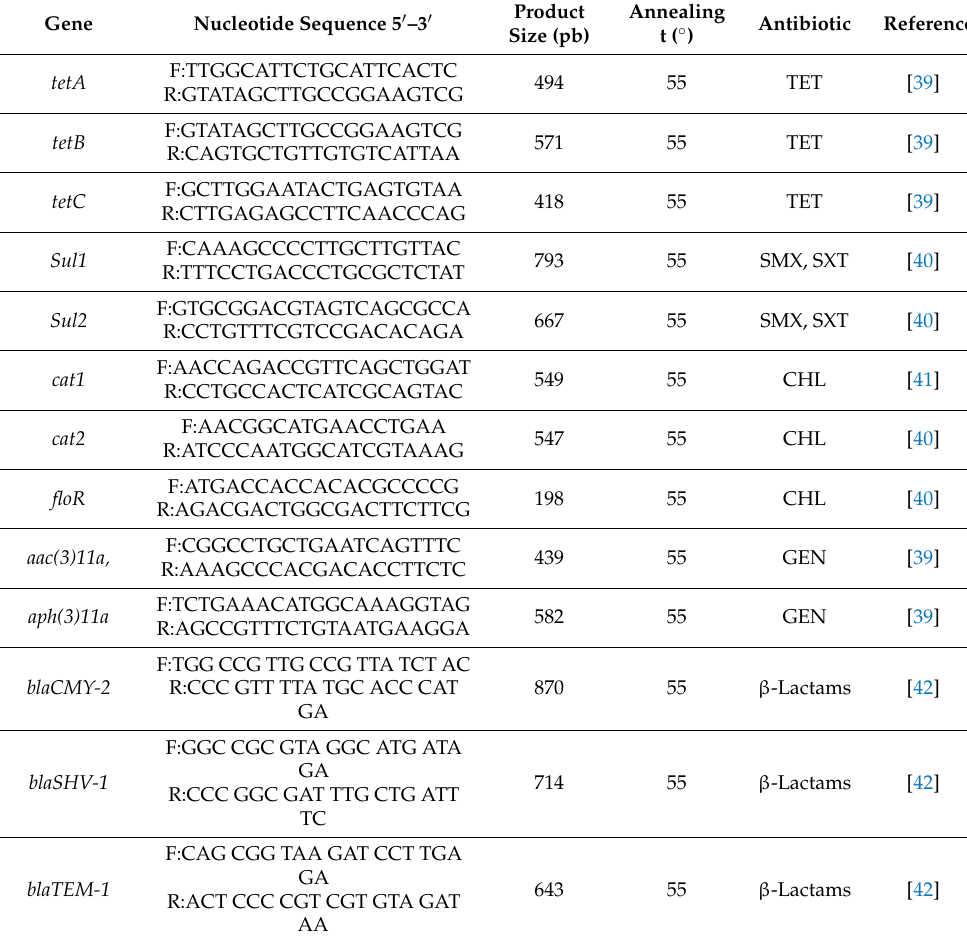
Table 3. Primer sequences and their annealing